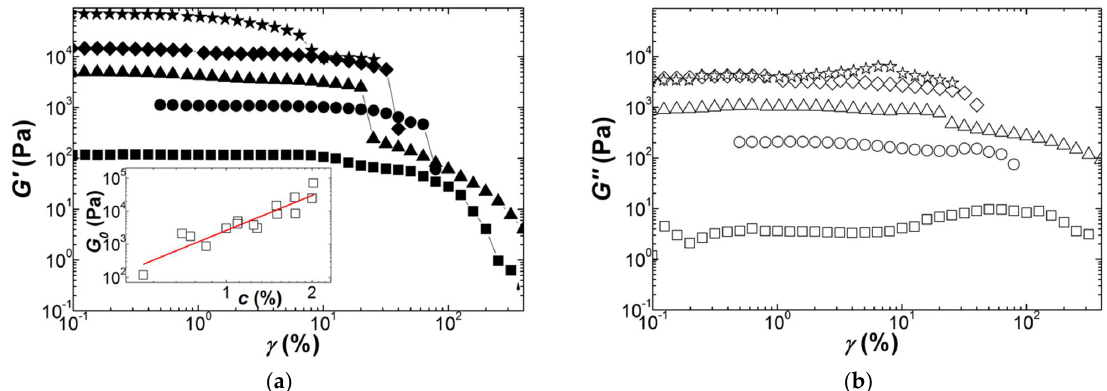
Figure 4. Response of Kappa gels (squares: 0.55 wt.%; circles: 0.75 wt.%; triangles 1.1 wt.%; diamonds: 1.5 wt.%; stars: 2 wt.%) to a sweep in the dynamic shear strain γ at 1 Hz and 20 °C: ( a ) storage modulus G′ ; ( b ) loss modulus G ″. Inset: concentration dependence of the storage modulus G 0 measured in the linear regime; the line is a power law fit to the data, returning an exponent of n = 3.5 ± 0.4.